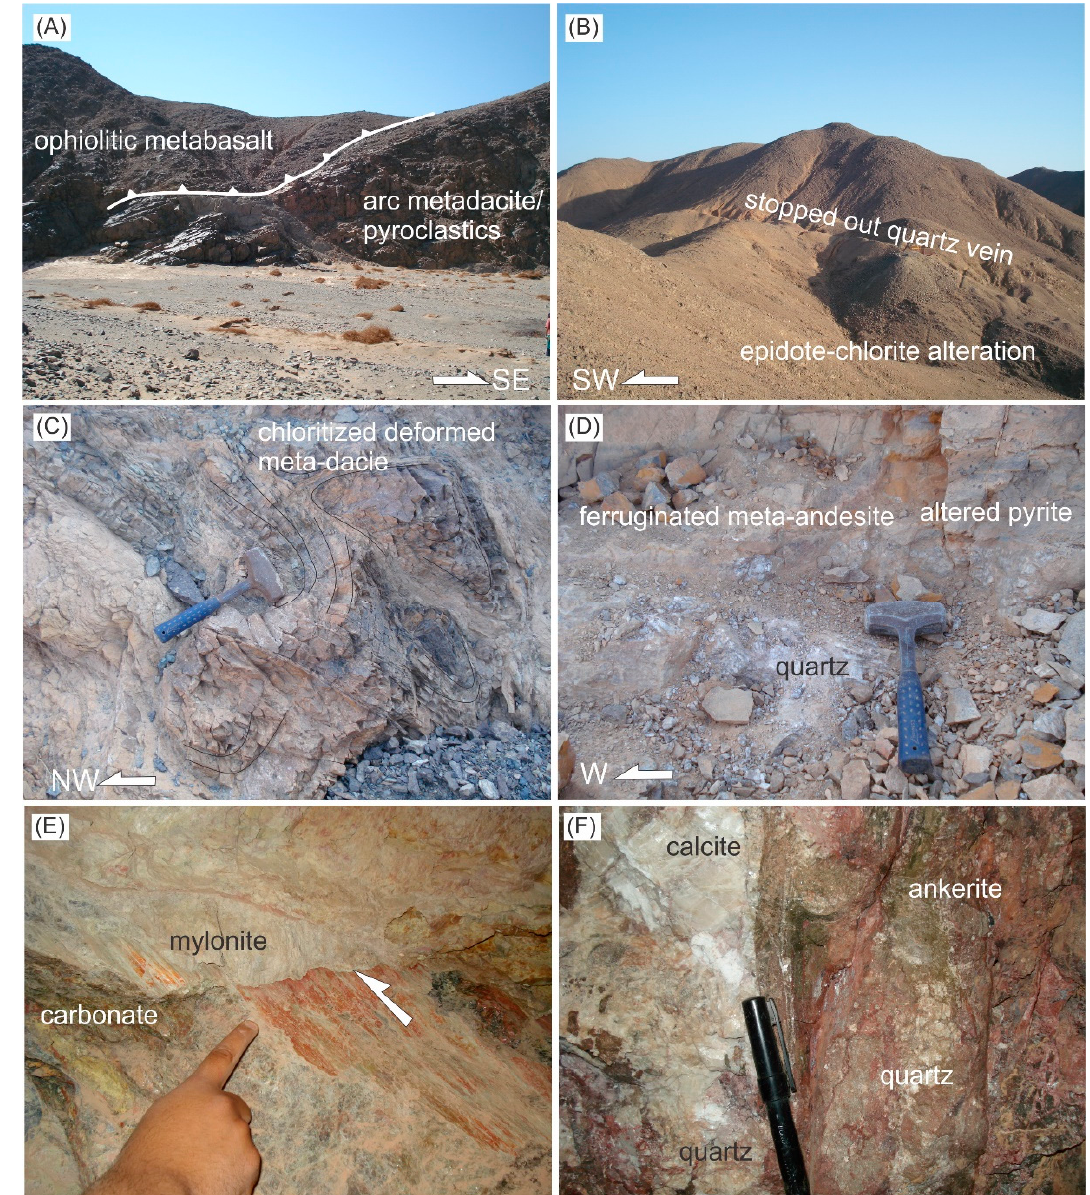
Figure 14. Field relationships at the Dungash mine area and its surroundings, including: ( A ) Ophiolitic metabasalt tectonically overlie the idland arc metavolcaniclastic rocks north of the Dungash mine, ( B ) Traces of ~ E–W trending gold-bearing quartz vein (main lode) and associated epitore–chlorite alteration in Dungash mine, ( C ) Deformed felsic metavolcanic rocks embedded in pervasively carbonated and chloritized material, ( D ) Disseminated altered sulfides and iron oxides (ferrugination) in the vicinity of mineralized quartz–ankerite vein, ( E ) Carbonate alteration along slicken planes on a reverse fault and associated mylonite zone in the underground levels of Dungash mine, ( F ) Ankerite and calcite associated with quartz veins.